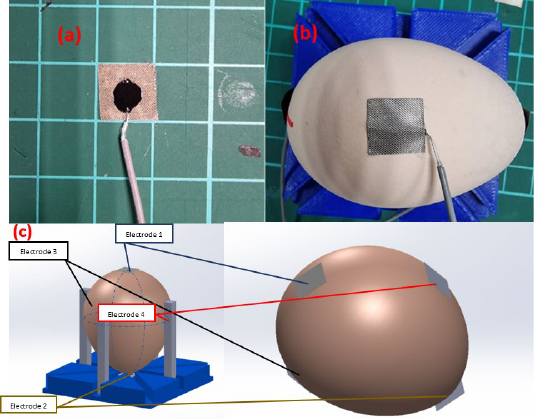
Figure 1. ( a ) Carbon epoxy was dropped onto 10 × 10 (mm 2 ) adhesive conductive cloth ( b ) taped onto designated points on a chicken egg using RG-1.13 mm coaxial cable on the ( c ) designated elec- trode